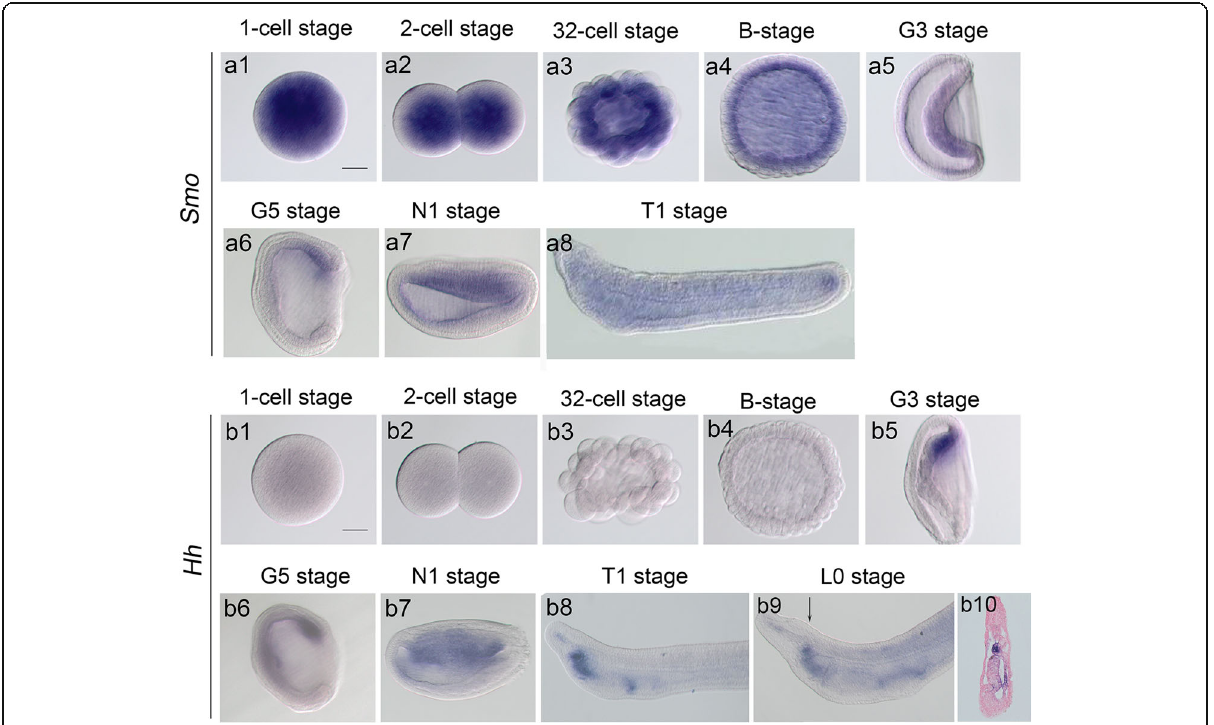
Fig. 1 The expression of Smo and Hh genes in developing amphioxus embryos. a1-a8: Expression patterns of Smo at eight stages of amphioxus development. b1-b10: Expression patterns of Hh at nine stages of amphioxus development. Smo exhibits strong maternal expression in fertilized eggs and early cleavage embryos. Hh gene shows zygotic but no maternal expression. Arrow in b9 indicate the section plane in b10. Scale bar, 50 μ